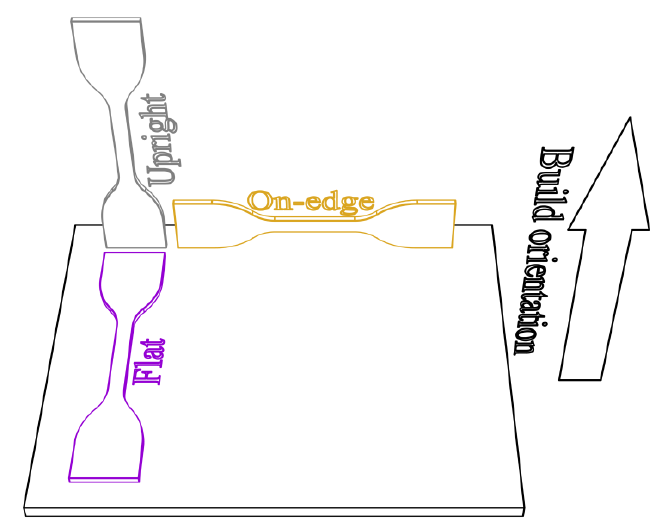
Figure 4. Three build orientations.